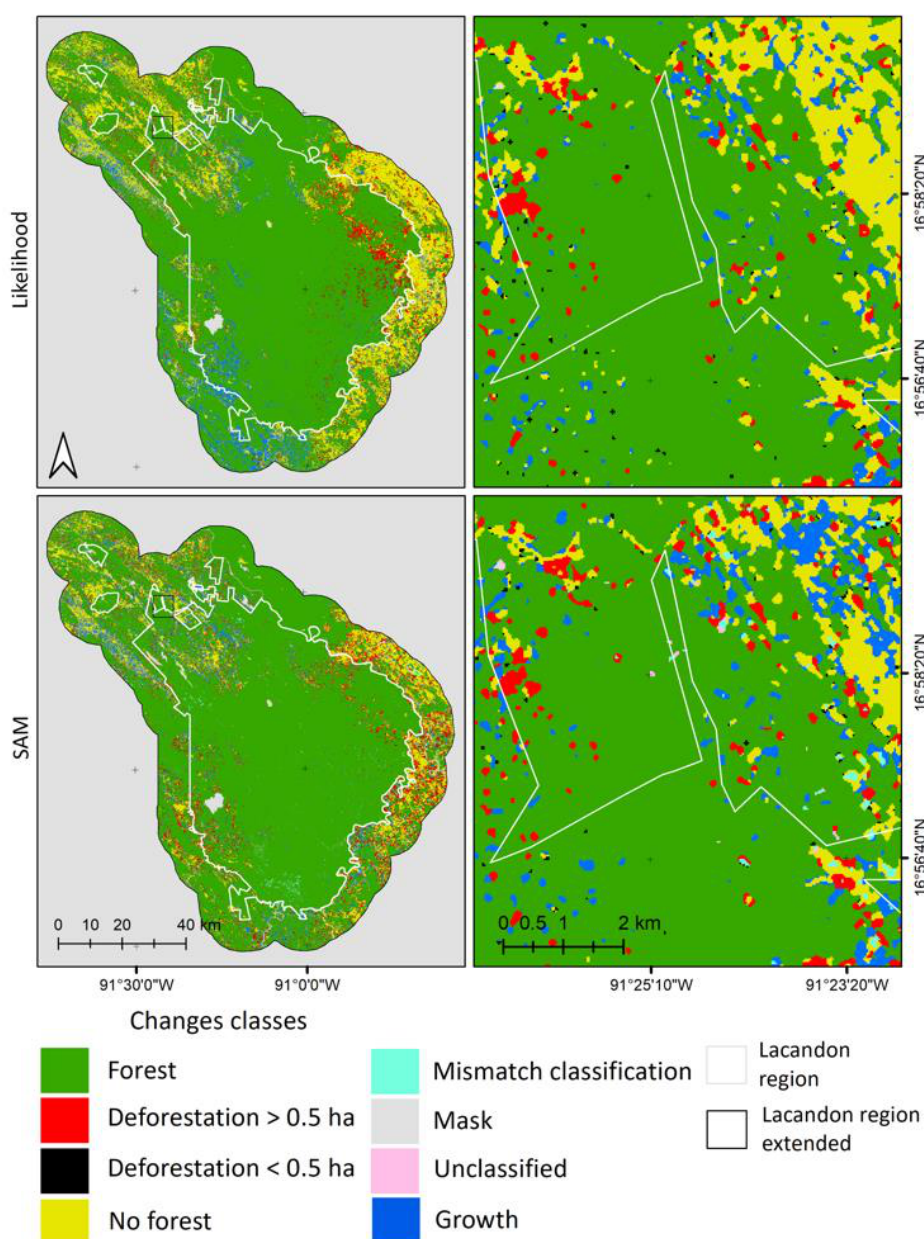
Figure 4. Land use changes for the likelihood and SAM classifications according to the FAO and regional definitions of deforestation (2015 and 2018), for the Lacandona and extended Lacandona regions, respectively. Left panels show maps using the likelihood and SAM classification algorithms. Right panels show maps of areas depicting details in land use changes. The FAO definition of deforestation is depicted in red; the regional definition of deforestation includes pixels in red and black. For these maps, forest class includes both no forest and urban infrastructure classes in Figure 3, respectively. See Methods for details.